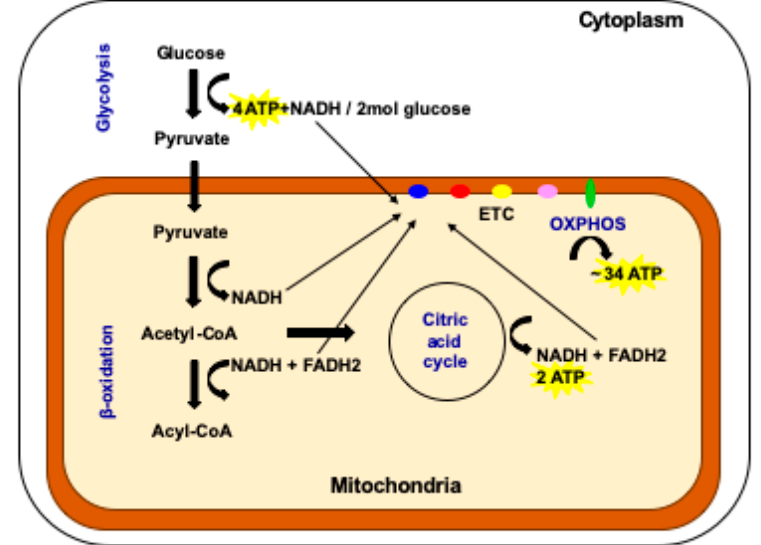
Figure 1. The multiple pathways available for the production of cellular ATP. In the cytoplasm of the cell, glycolysis generates four molecules of ATP for every two molecules of glucose invested. This is the pathway favored by fast replicating cells. In the mitochondrion, the processes of β -oxidation, the citric acid cycle and OXPHOS take place. OXPHOS is favored by cells with complex functions. Two molecules of ATP are generated by the citric acid cycle and 34 molecules are generated by OXPHOS (adapted from reference [20]).